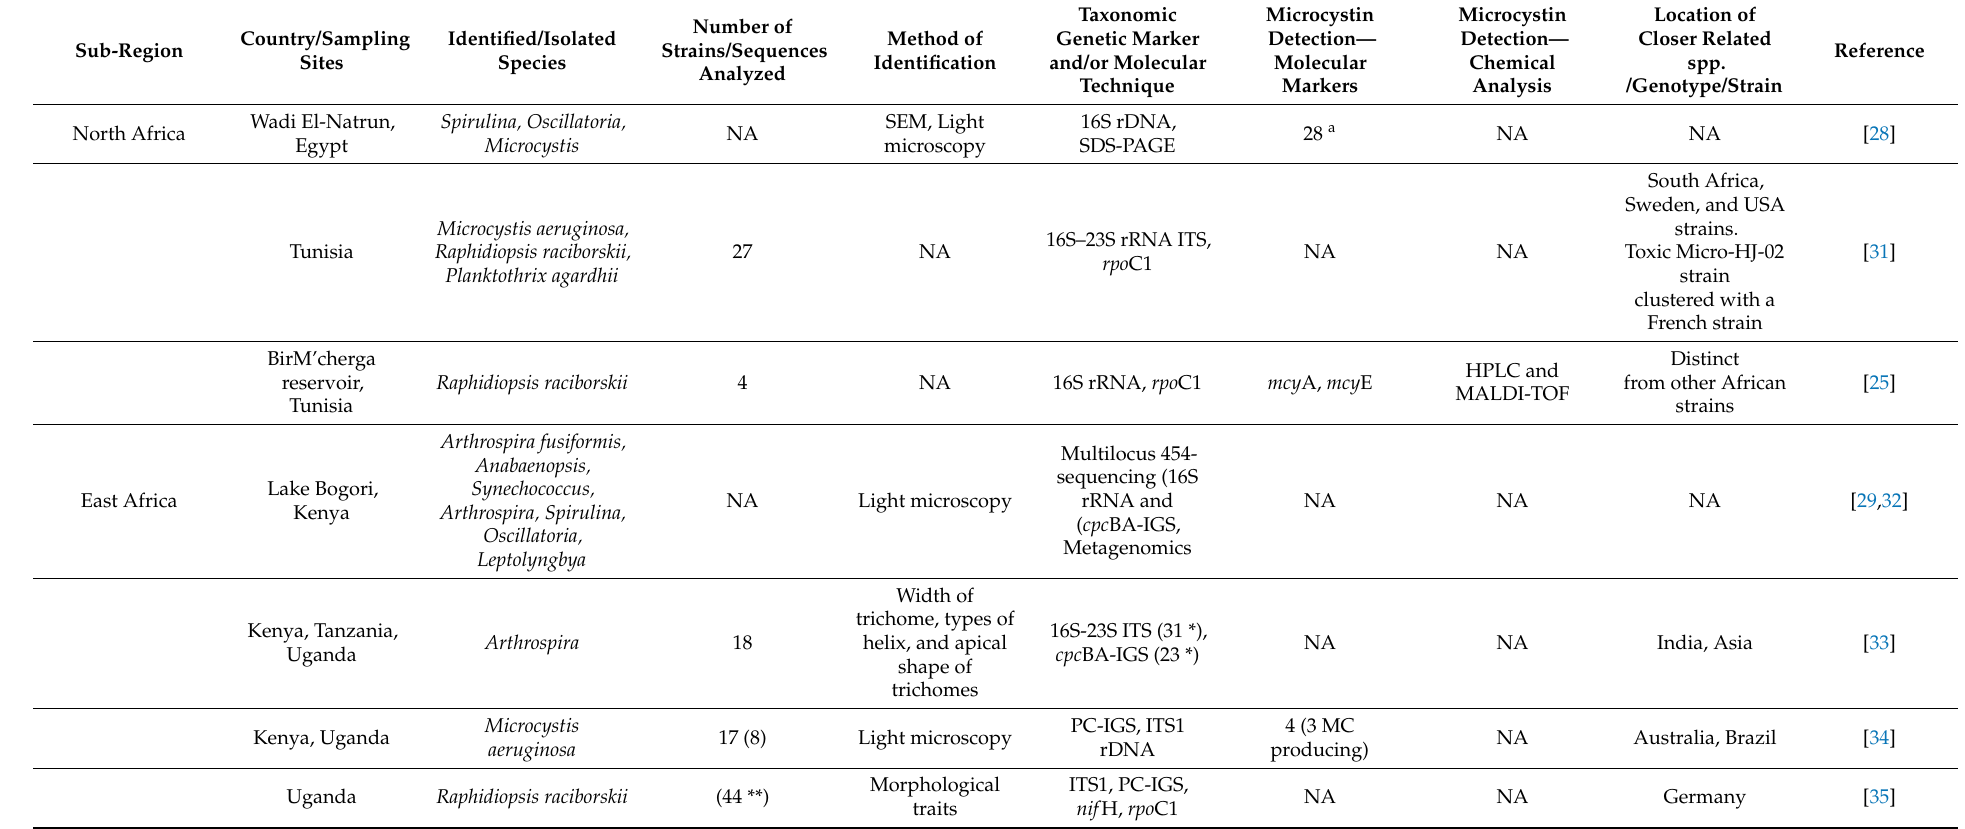
Table 1. Compilation of geographic and molecular information from African cyanobacterial